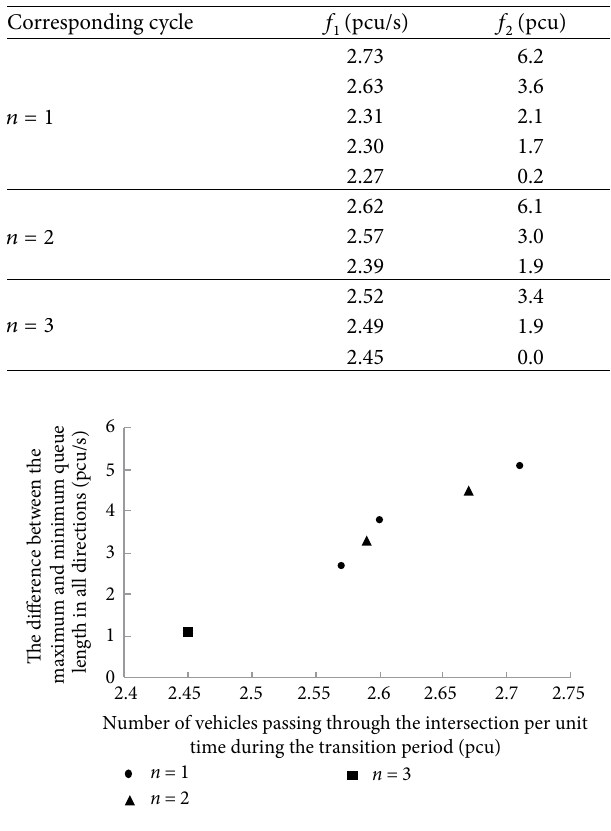
Table 2: Pareto frontier with different n when t